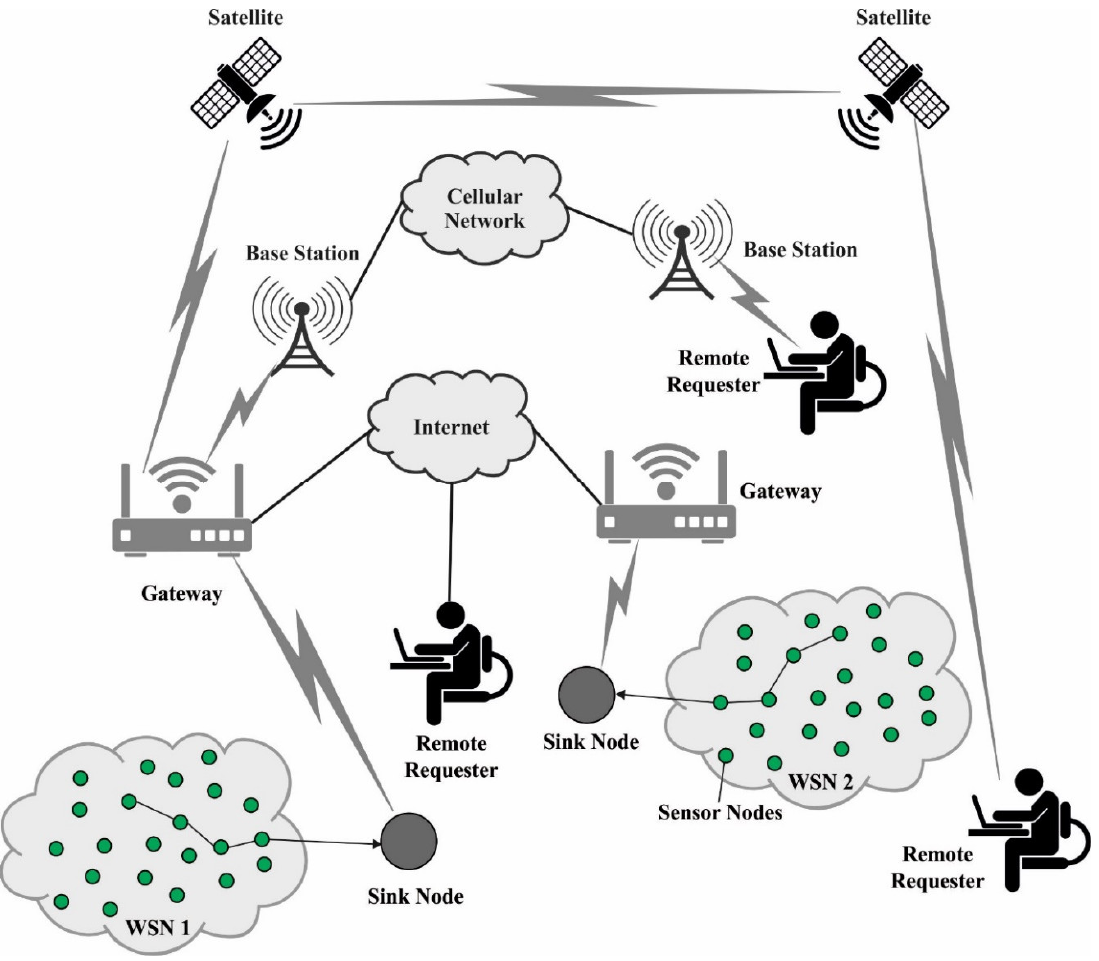
Figure 1. Routing protocol for WSNs.